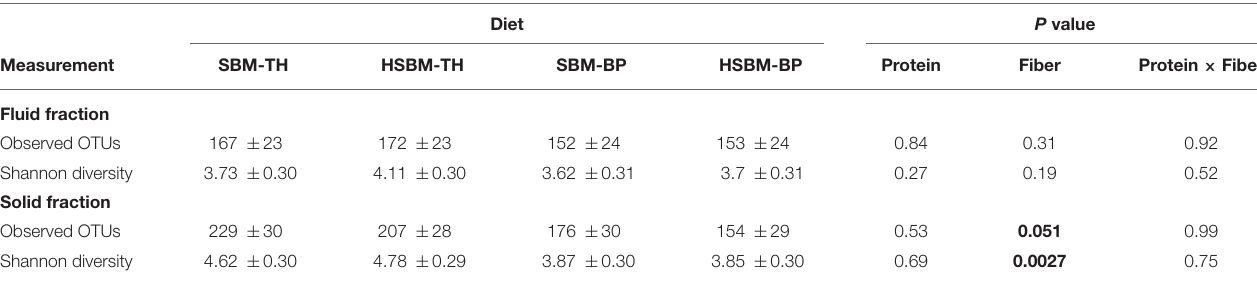
TABLE 4 | LS means ± SE for alpha diversity metrics of the bacterial community identified in the rumen fluid and solid fractions as differentiated by diet along with P values for the effects of protein source, fiber source, and the interaction of protein and fiber source a .